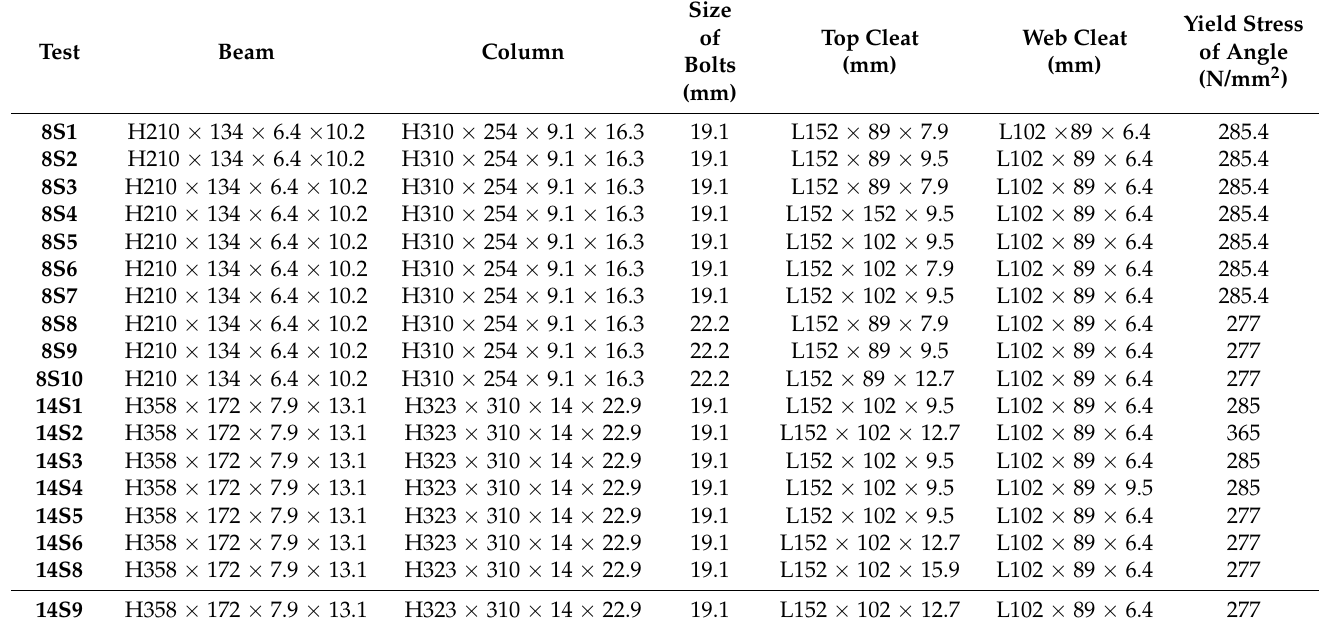
Table 1. Geometrical and mechanical characteristics of selected TSACW